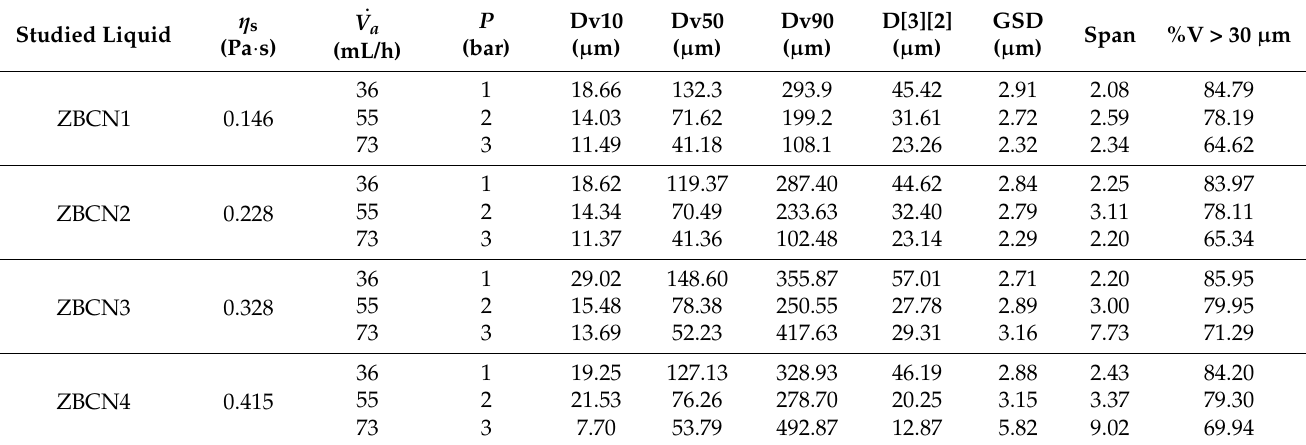
Table 2. The obtained test results and the operation